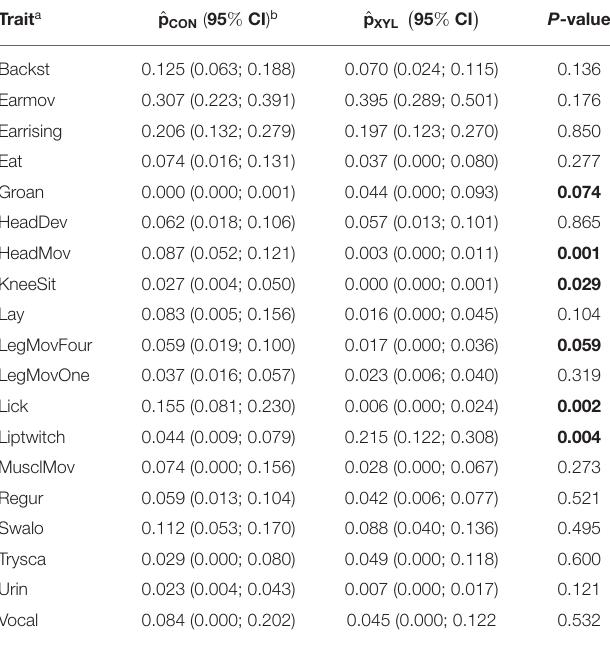
p i of occurrence of behavioral traits for the TABLE 5 | Estimated probabilities ˆ treatments (CON, XYL), their 95% CI, and significance test of differences between treatments ( P -value, t